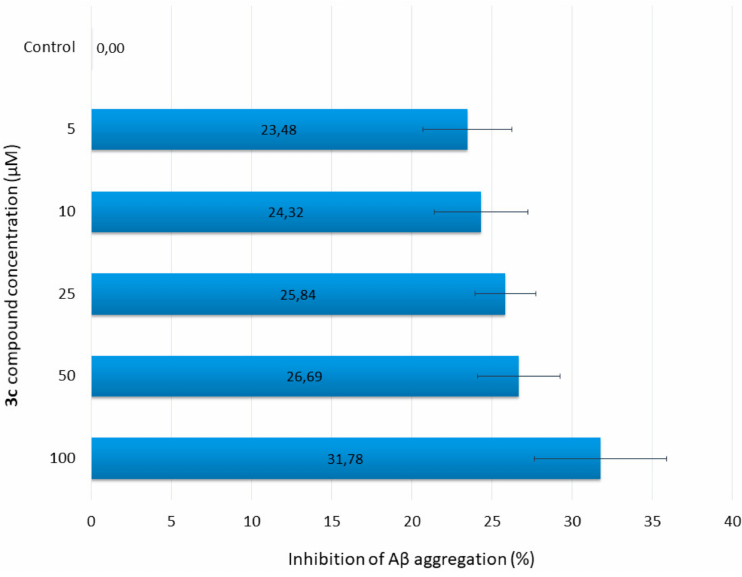
Figure 2. Inhibition of A β aggregation by various concentrations of 3c